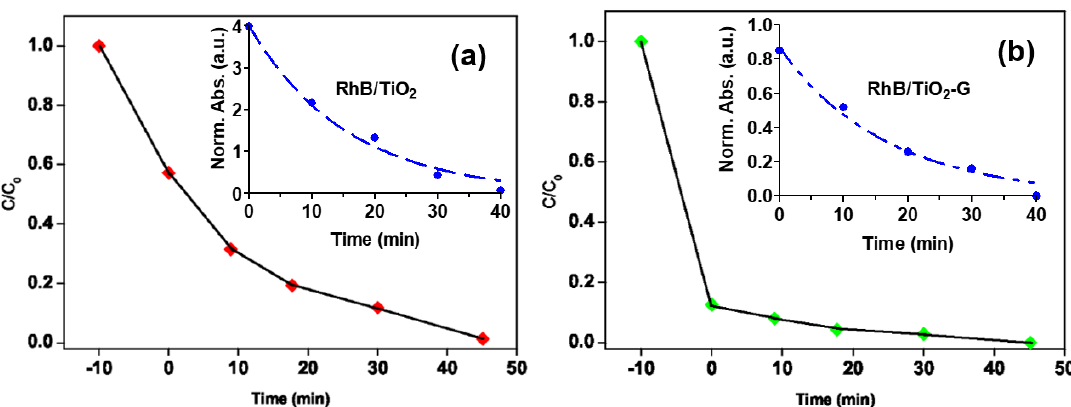
Figure 8. ( a ) Plot of C / C 0 for the degradation of rhodamine-B (RhB) dye in the presence of TiO 2 with di ff erent time intervals at UV light and ( b ) during the same process for the RhB / p-C / TiO 2 suspensions under identical conditions. The region between − 10 and 0 min implies the adsorption of the RhB dye under dark conditions. The inserts show the photodegradation of the RhB dye by first-order kinetics. As expected, the p-C / TiO 2 samples displayed greater adsorption of the dyes compared to pristine titania (from − 10 to 0 min in Figures 7 and 8, respectively, for MB and RhB). Samples were then